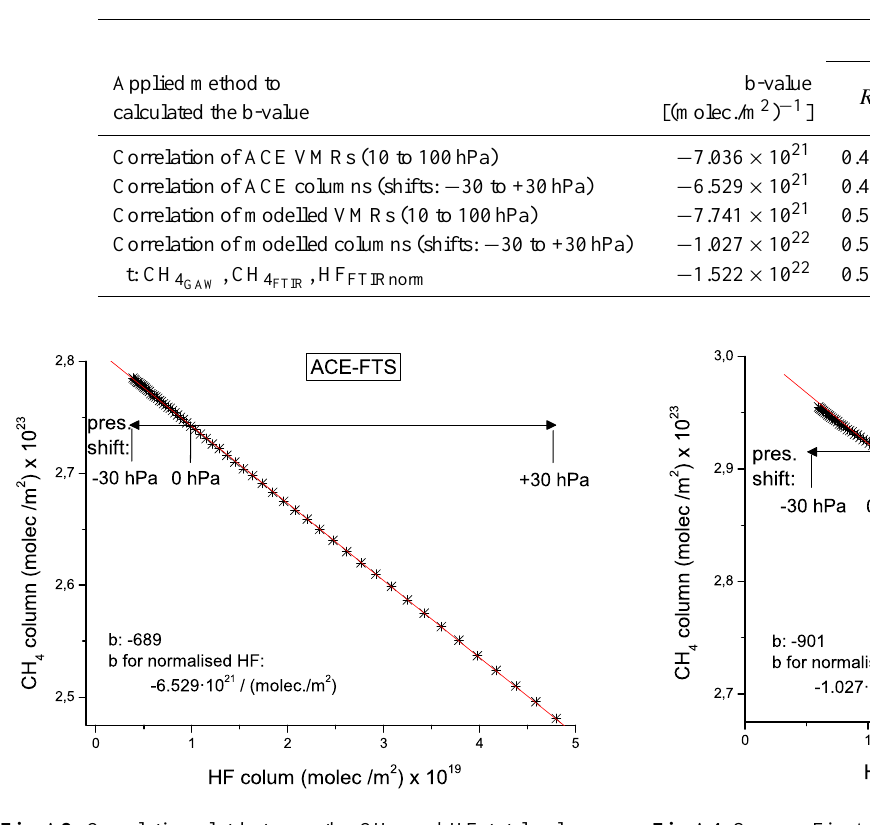
Fig. A4. Same as Fig. A3 but for model